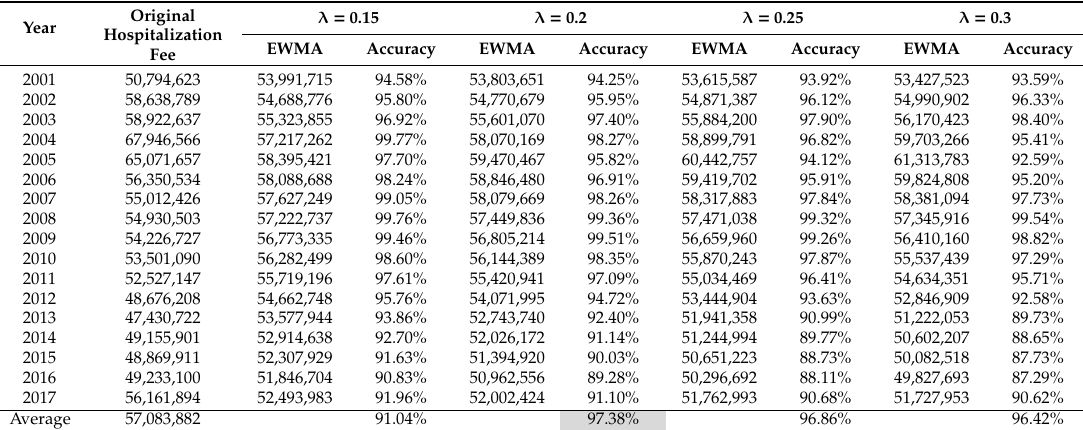
Table 2. λ sensitivity analysis of diabetes hospitalization fees in 2001–2017 (USD).